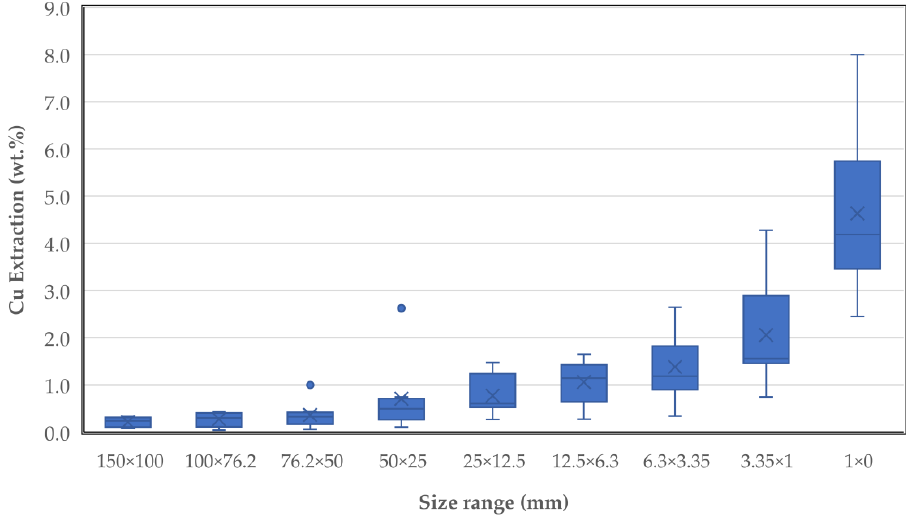
Minerals 2023 , 13 , x Figure 10. Scatter plot of Cu extraction versus stockpiling time for the bulk samples from the stockpile.